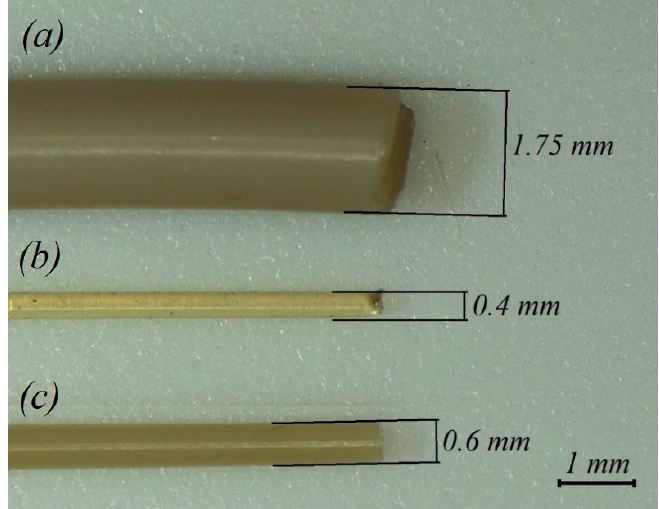
Figure 3. ( a ) As-delivered filament from coil; ( b ) filament extruded via 0.4 mm nozzle before heat treatment; and ( c ) filament extruded via 0.6 mm nozzle after heat